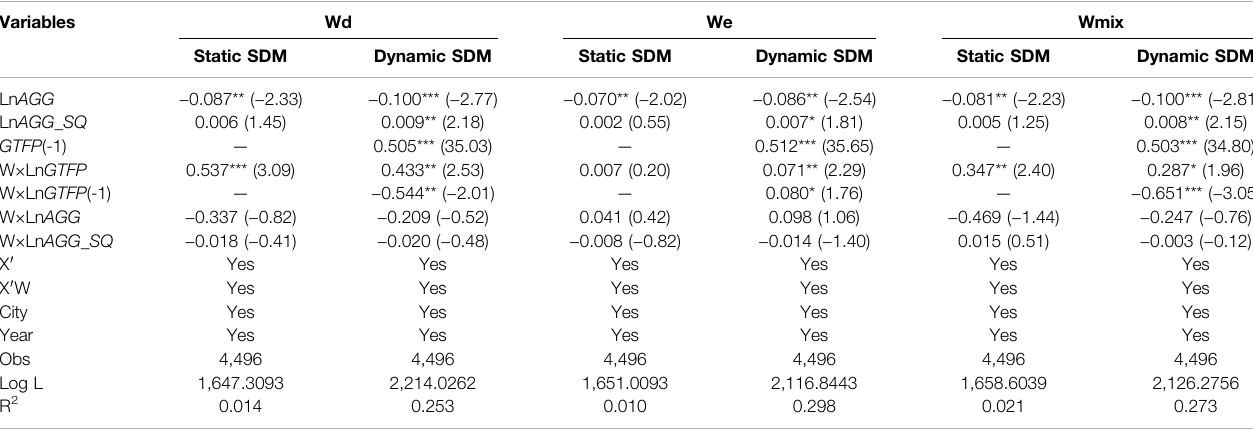
TABLE 4 | Spatial econometric estimation results under different spatial matrices.